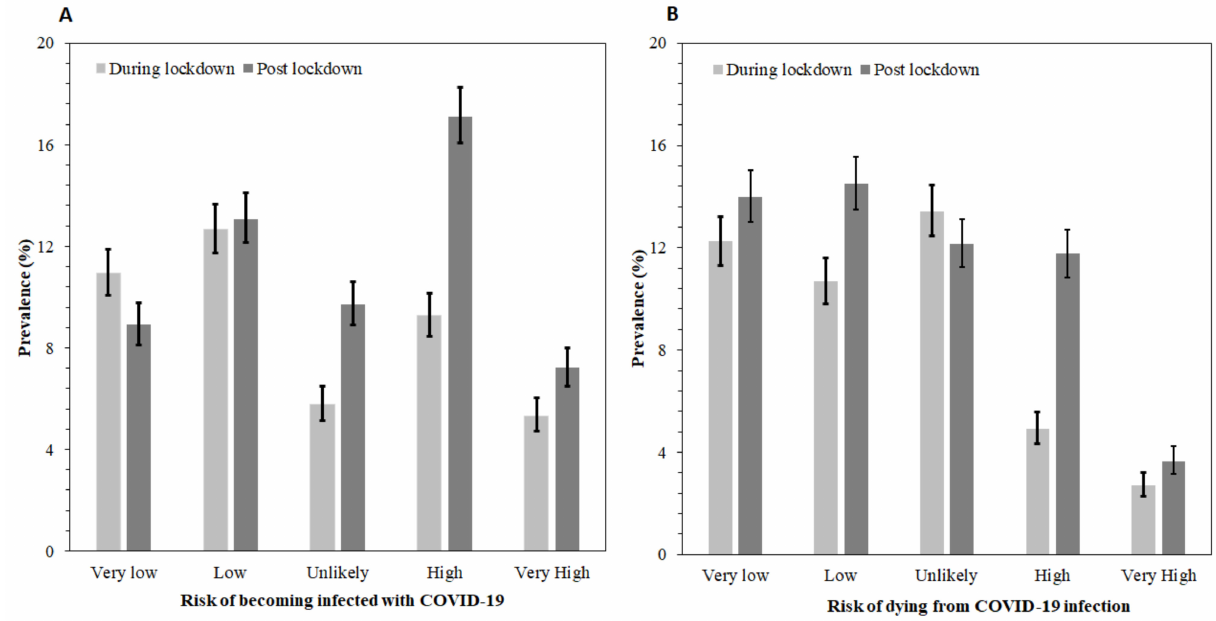
Figure 1. Proportion of responses for perceived risks of COVID-19: ( A ), the risk of becoming infected with COVID-19; ( B ) the risk of dying from COVID-19 infection Error bars are 95% confidence intervals. Unlikely means no risk.